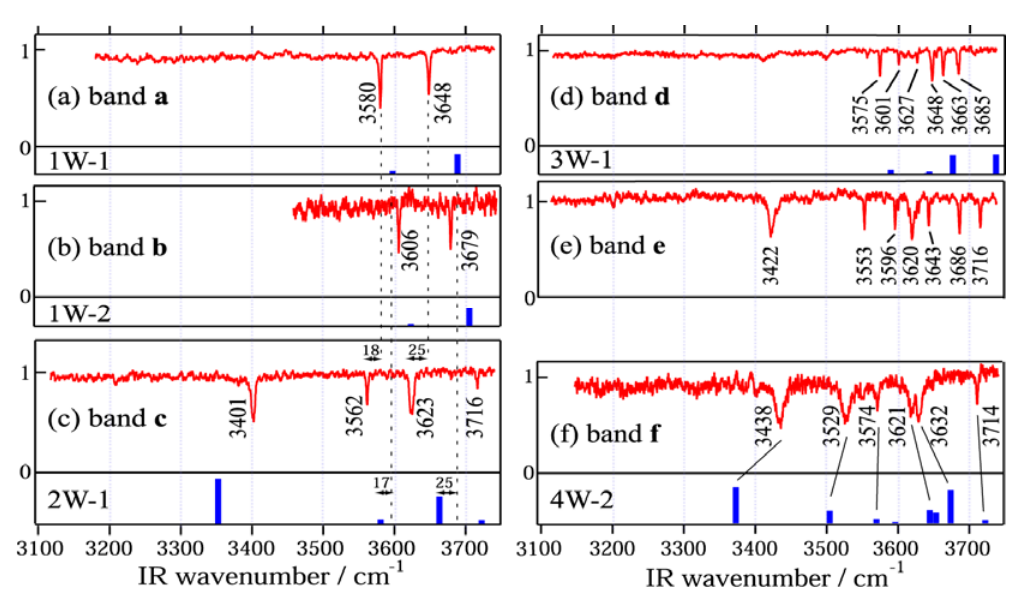
Figure 5. (a)-(f) IR-UV DR spectra of DB18C6-(H